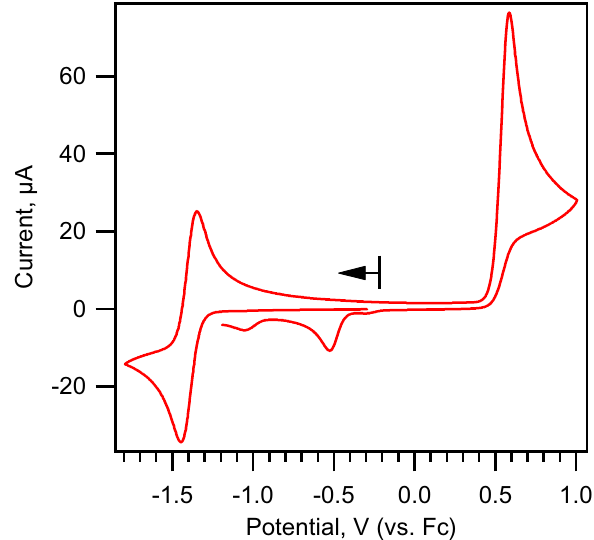
Figure 1. Cyclic voltammogram of 2 mM [(C 4 H 9 ) 4 N] 3 [Fe III (CN) 6 ] in anhydrous acetonitrile. Scan rate: 100 mV/s. 3 mm diameter GC working electrode.